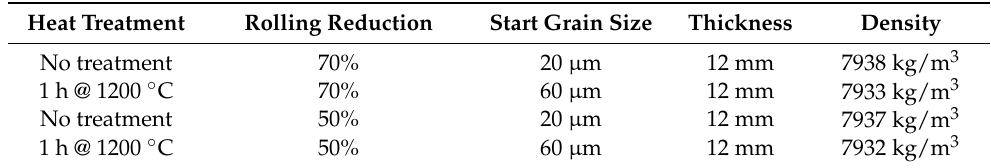
Table 1. Description of sample